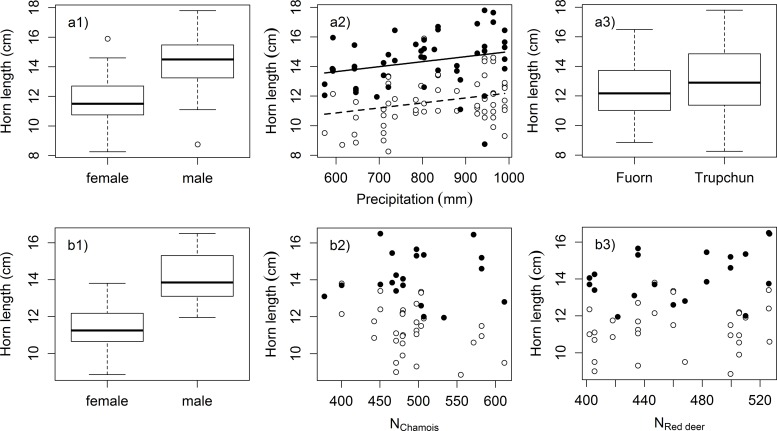
Horn growth.Chamois horn growth during the kid and yearling years combined vs. explanatory variables in regional (Val Trupchun and Il Fuorn combined; a1-3) and local (Il Fuorn only; b1-3) linear models. Open symbols in scatterplots represent females, closed symbols males. Plots are shown for all parameters with predictor weights > 50%, but regression lines are only included for continuous variables retained in the most parsimonious model within ∆AICc ≤ 2.